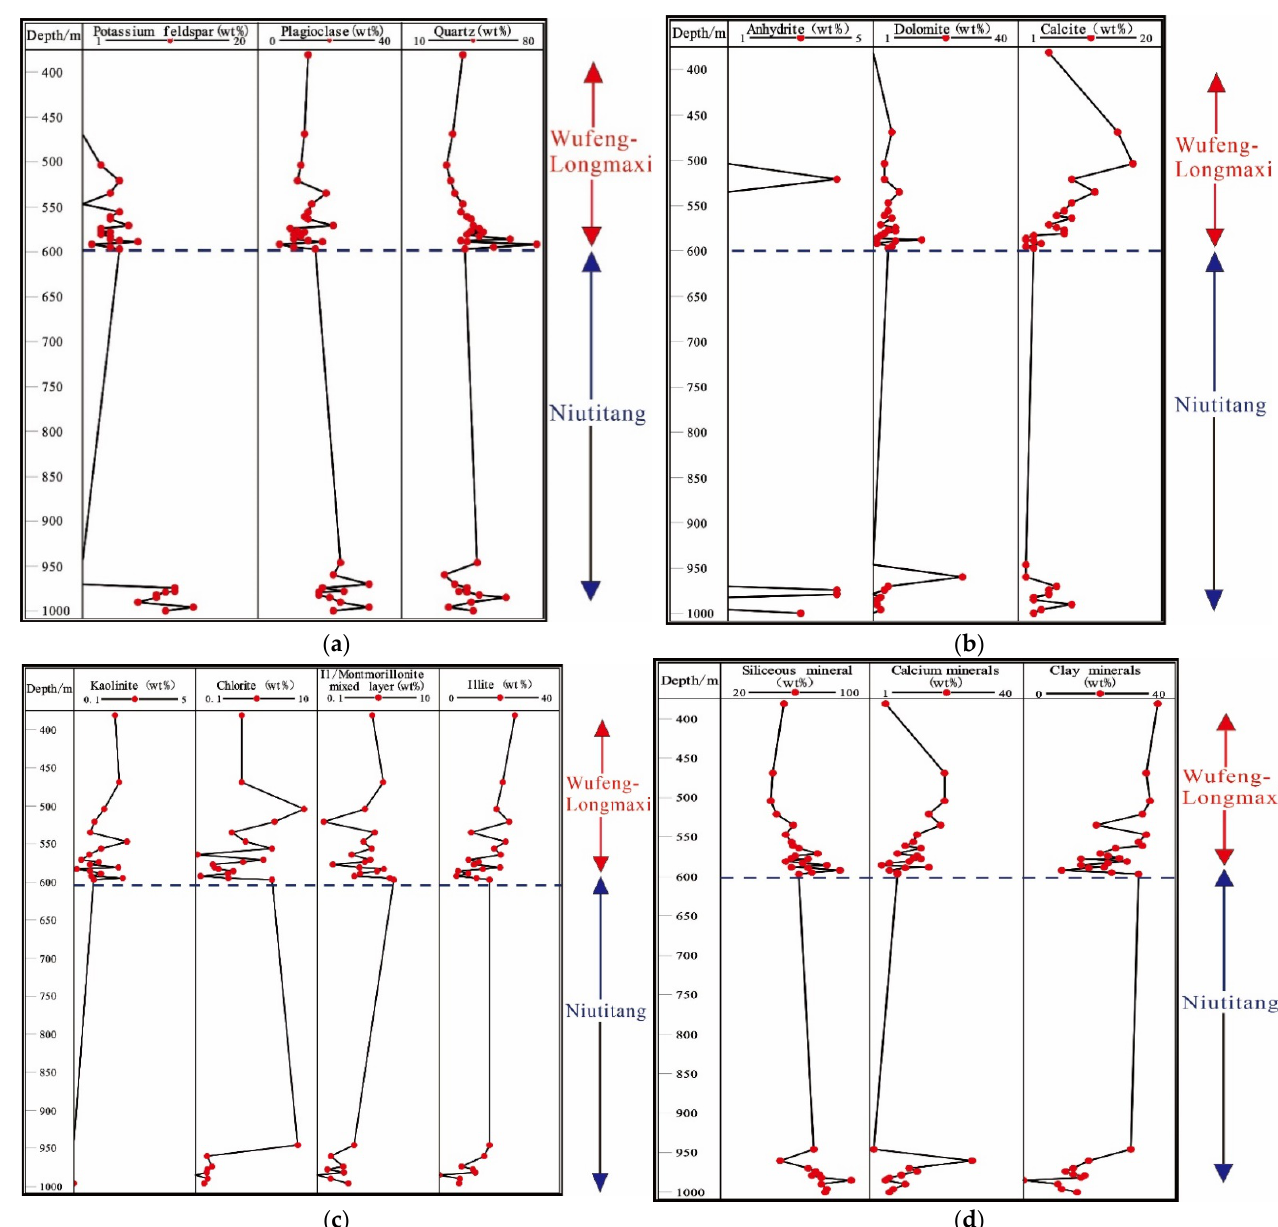
Figure 3. Mineral composition characteristics of the Wufeng-Longmaxi and Niutitang Formations in northern Guizhou Province. ( a ) Siliceous mineral composition (quartz, plagioclase, and potassium feldspar); ( b ) calcareous mineral composition (calcite, dolomite, and anhydrite); ( c ) clay mineral composition (kaolinite, chlorite, illite, and il/montmorillonite mixed layer); ( d ) total mineral composition (siliceous minerals, calcium minerals, and clay minerals). Based on organic geochemical features and mineral compositions, shales of the Wufeng-Longmaxi Formation and Niutitang Formation can be divided into six different